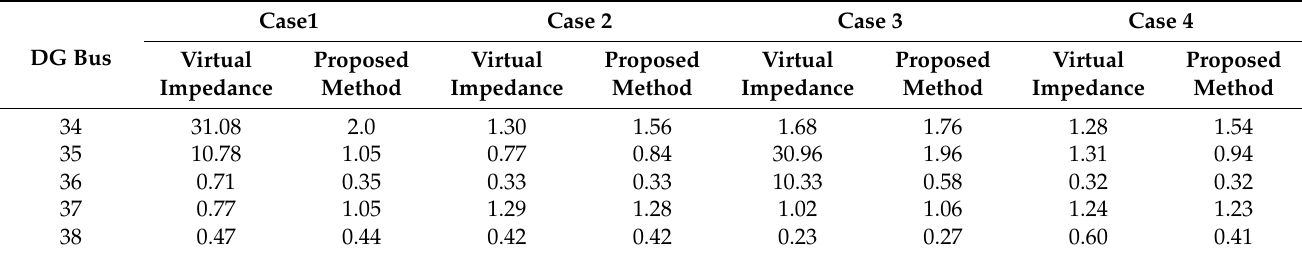
Table 6. The calculated output short circuit current of the DG buses throughout the fault in two approaches.